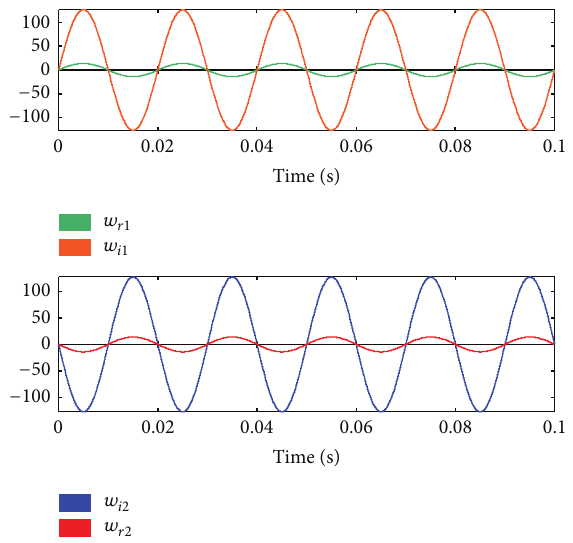
Figure 5: Reflected and incident waves for the 𝑉𝑅 circuit.